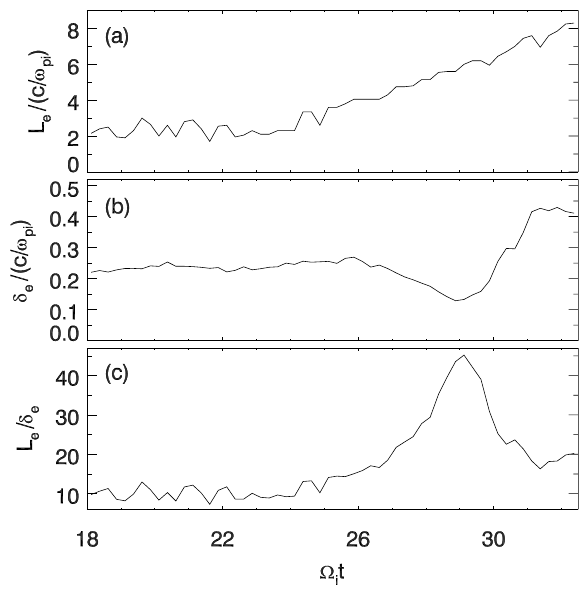
Fig. 3. The time evolutions of the characteristics of the ECS, (a) the length L e , (b) the half-width δ e , and (c) the ratio of the length to the half-width L e /δ e